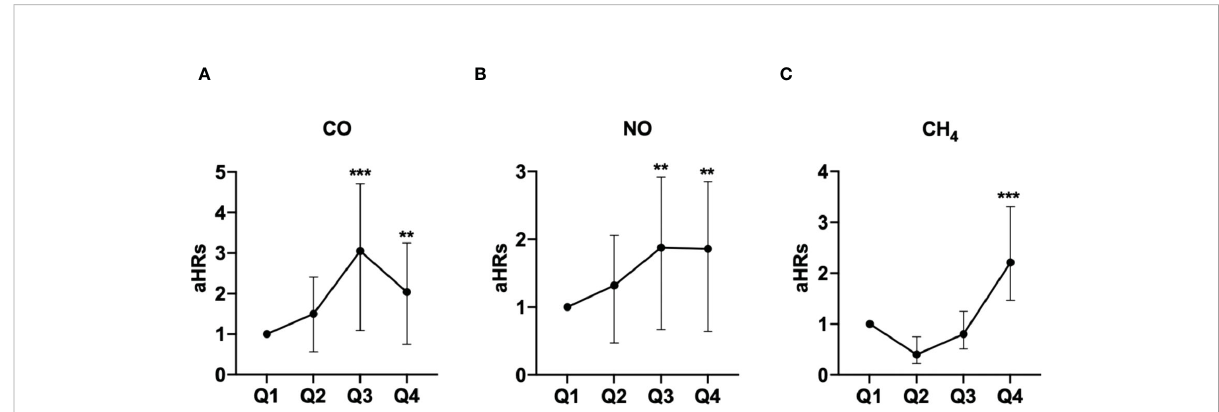
FIGURE 1 Illustrated hazard ratios (HRs) of pSS in individuals exposed to carbon monoxide (CO) (A) , nitric oxide (NO) (B) , and methane (CH 4 ) (C) . **p<0.01;